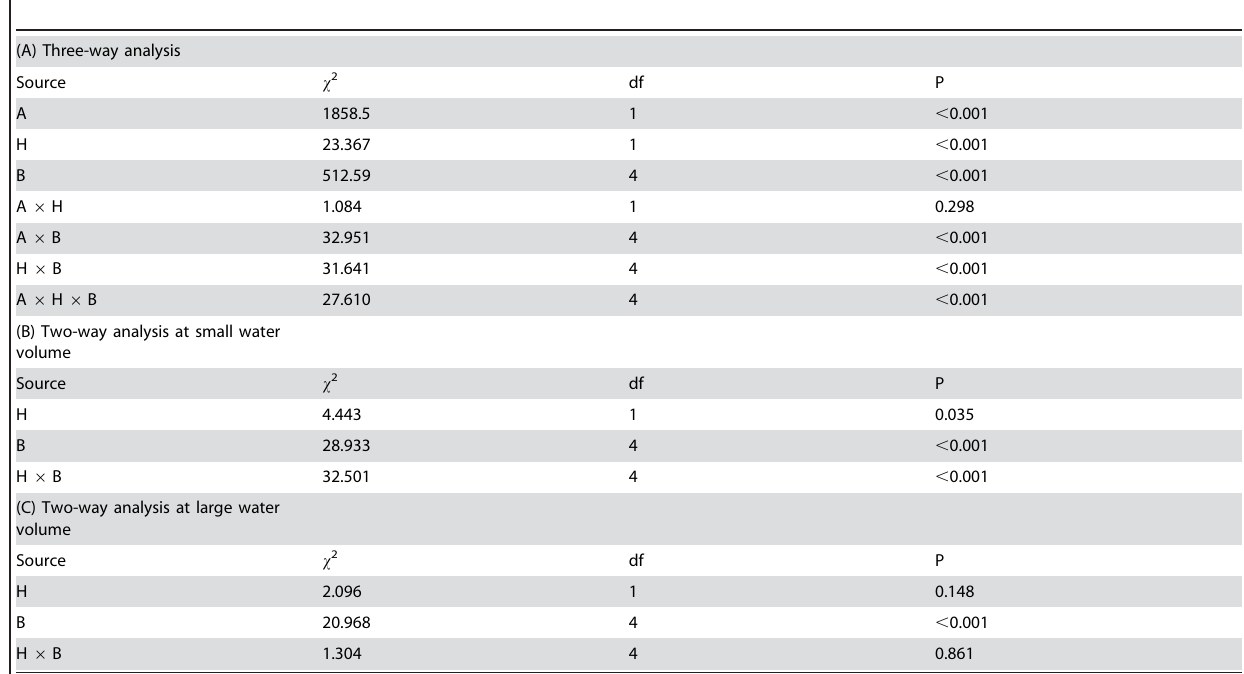
Table 5. Effects of water volume (V), water heterogeneity (H), and belowground herbivore (B) on plant